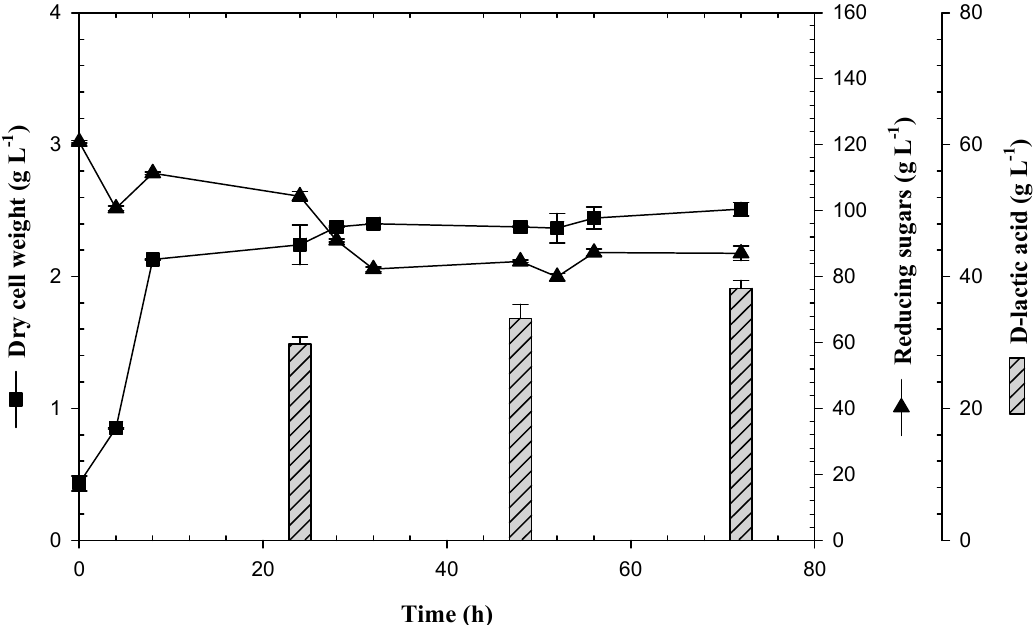
Figure 2. Kinetic of Escherichia coli JU15 in a fed-batch bioreactor at 110 g L − 1 initial reducing sugars, 200 rpm, 37 °C, and pH 6.6. The arrow indicates the time of starting feed with fresh medium (40 g L − 1 reducing sugars). Data from two independent experiments are shown.